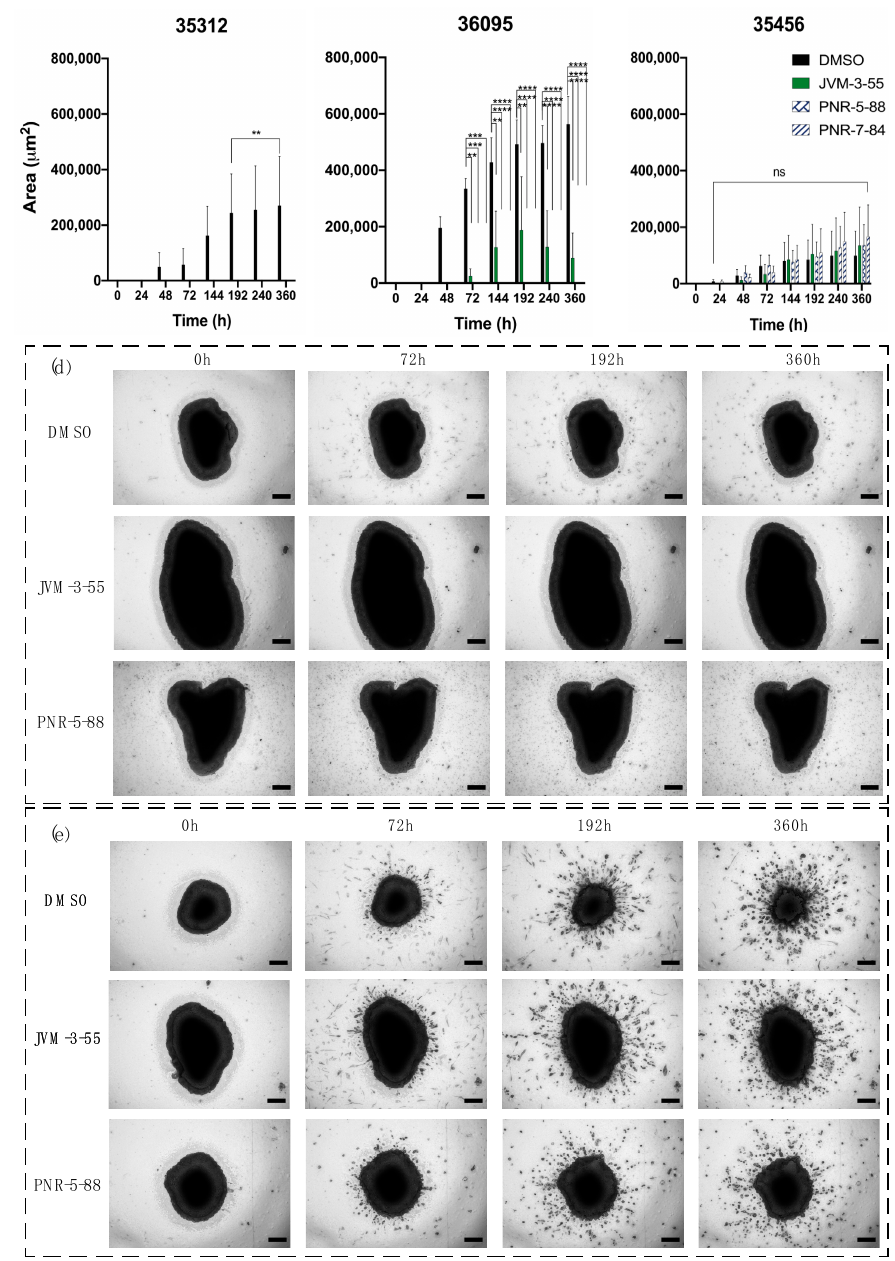
Figure 5. Evaluation of invasion ability of selected compounds on GBOs from different patients. The invasion was determined by automatic measurement of the area of cells invading into the matrix ( µ m 2 ) in a function of the different times of incubation for patients ( a ) 35312, ( b ) 36095, and ( c ) 35456. The statistical analysis for significance was done using two-way ANOVA with the control (DMSO) for the different times of invasion as the comparative model with the Dunnett model, ns (non -significant) for adjusted p > 0.05,** for adjusted p ≤ 0.01, *** p ≤ 0.001, and **** p ≤ 0.0001. For each experiment, n = 3. Brightfield images were recorded on Cytation 5 using a 4 × objective lens, in z-stacks of embedded GBOs in the matrix for 0, 72, 192, and 360 h with either DMSO, JVM-3-55, or PNR-5-88 for patients 36095 ( d ) and 35456 ( e ). Scale bar: 200 µ